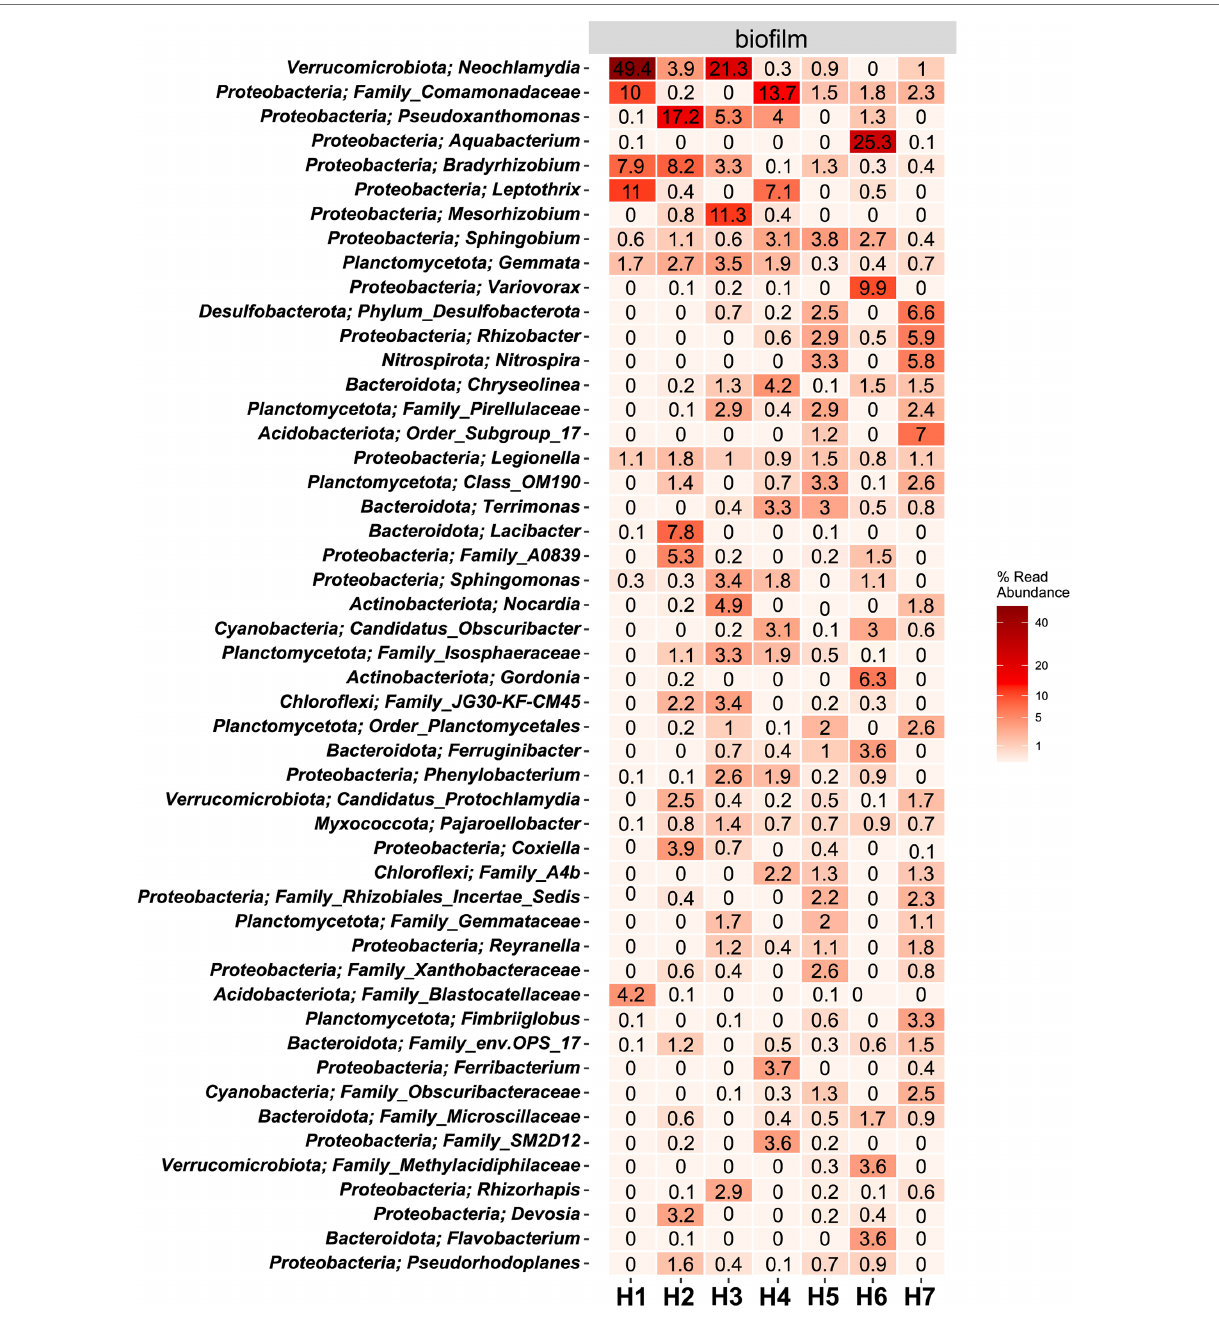
FIGURE 5 | Heat map of the top 50 most abundant genera (and their belonging phylum) in biofilm samples. The average ASV counts from replicate 16S rRNA gene libraries for each category are shown. Numbers represent the read abundance in